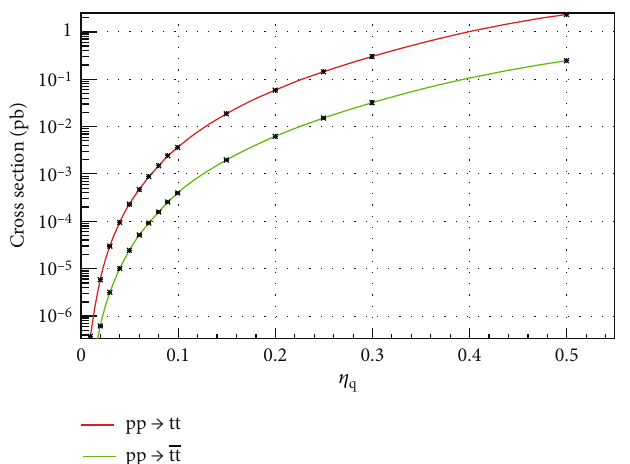
Figure 4: Estimated cross sections according to coupling constant of two same-sign lepton signal in FCNC processes. As we can see, the main contribution comes from positively charged top pair due to higher parton distributions of valance quarks at proton which di ff ers nearly one order of magnitude. Nevertheless, adding (cid:1) t (cid:1) t production, we use negatively charged lepton pair to enhance the signal process. We assume all FCNC coe ffi cients are the same and all channels are open (to state exactly we use u + c ⟶ η